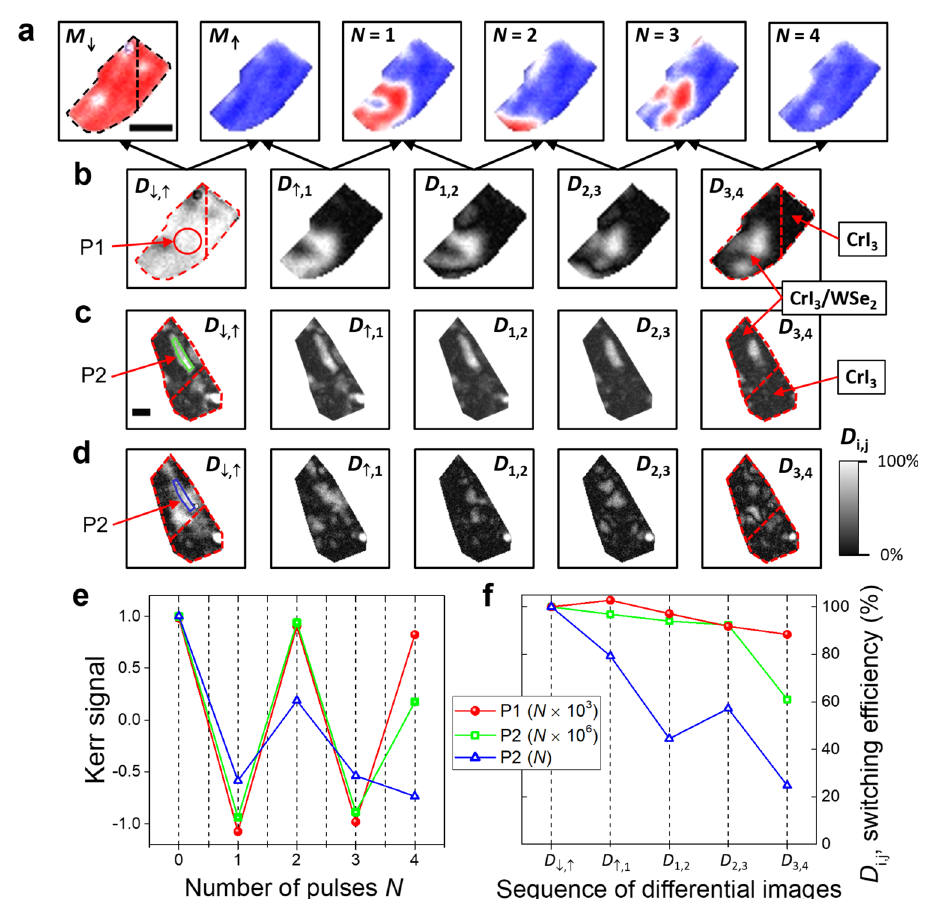
Fig. 4 | Demonstration of toggle AOS with linearly polarized pulses for a CrI 3 (10nm)/WSe 2 (1L) heterostructures (samples 2 and 3). a The remanent M ↓ and M ↑ mono-domain states for sample 2, and the M ↑ remanent state after expo- sure to N bunches of 10 3 pulses. b Differential Kerr signal D i,j = ∣ ð M i (cid:2) M j Þ ∣ = ∣ + ∣ M ∣ Þ imagesextractedfromtheimagesin a .Differentialimagesforsample3 ð ∣ M i j